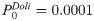
Simulation results for a model fly eye of size 30 × 50 obtained via the general response function of our model (Eq 6).The parameter α quantifies the relative importance of stochastic decisions. In: (a) α = 1. This models a perfect Doli fly, where there are no mistakes; (b) α = 0. This models Drosophila, where the two colors are randomly distributed, with a bias towards the green; (c) α = 1. This models a Doli fly a perturbed column (eighth from right). Notice that the perturbations propagate leftward to the end, giving rise to a domain with a discernible boundary. (d) α = 0.7. The parameters ϵ (local speckle correlation coefficient) = 0.95, P0Doli=0.0001 and P0Droso=0.75 were chosen with a view to match, at least qualitatively, the patterning of the intermediate, partially organized Chrysosoma sp. shown in Fig 1d.